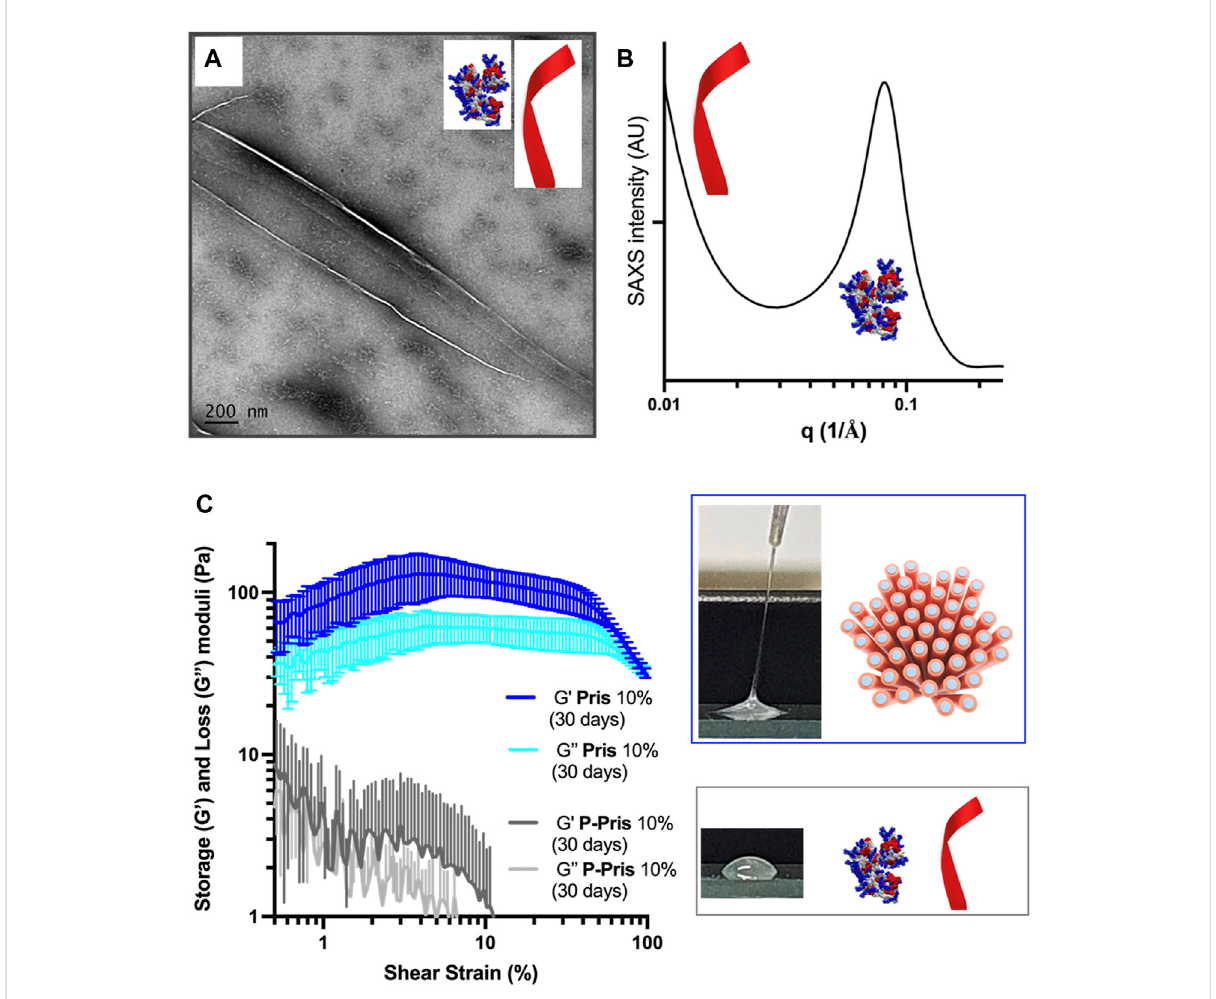
FIGURE 7 Peptide species (A,B) and rheological behaviour (C) of 10% wt P-Priscilicidin pure water solutions aged for 30 days at 5 ° C compared to (C) the rheological behaviour and macroscopic appearance of 10% wt Priscilicidin hydrogels aged under the same conditions. Image (A) : scale bar 200